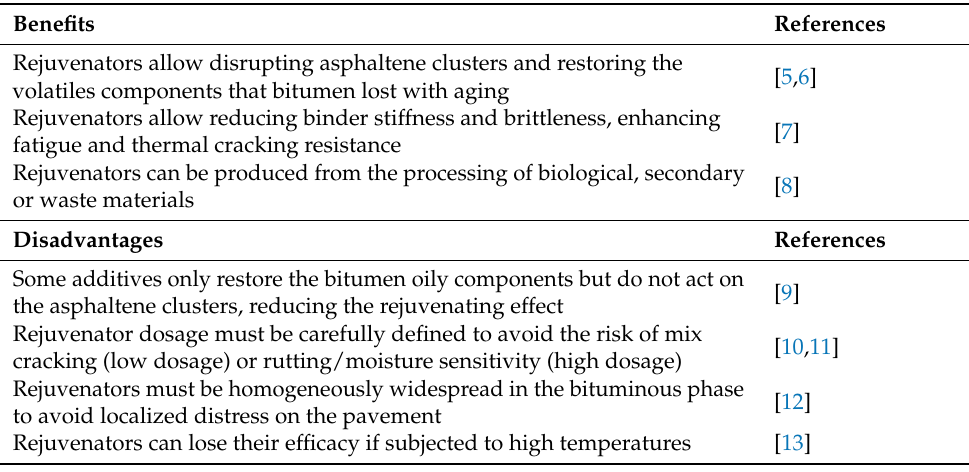
Table 1. Summary of the benefits and disadvantages of rejuvenating